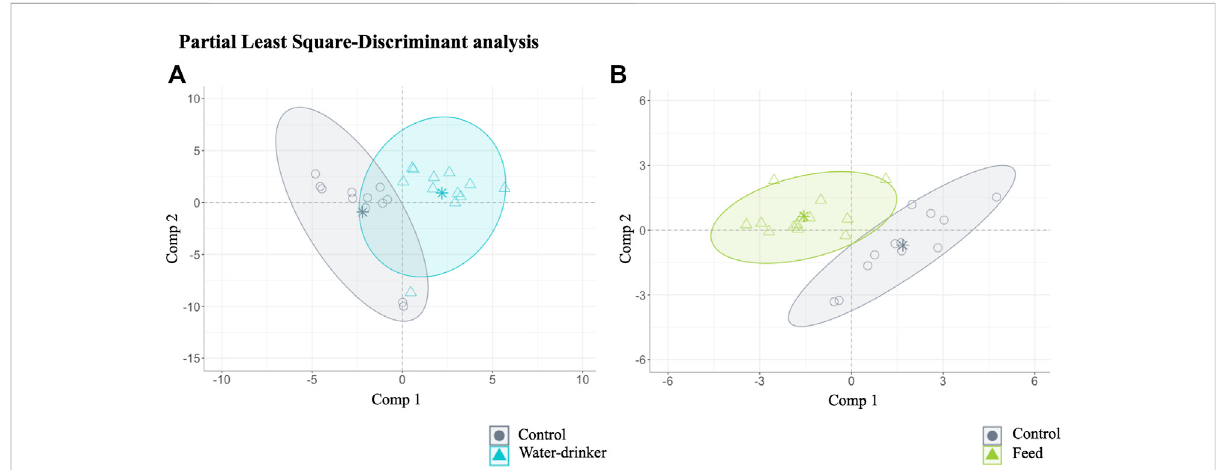
FIGURE 4 Thecaecalmetabolomefeaturescharacterisedfor Salmonella -freebroilerstreatedwitha Salmonella phage.Caecalmetabolomecomposition dissimilaritythroughtherepresentationofthe fi rst(Comp1)andsecondcomponents(Comp2)oftheidenti fi ed70relevantvariables(metabolites)in the fi nal partial least square-discriminant analysis (PLS-DA) models (A) from the water vs. control groups, and (B) from the feed vs. control